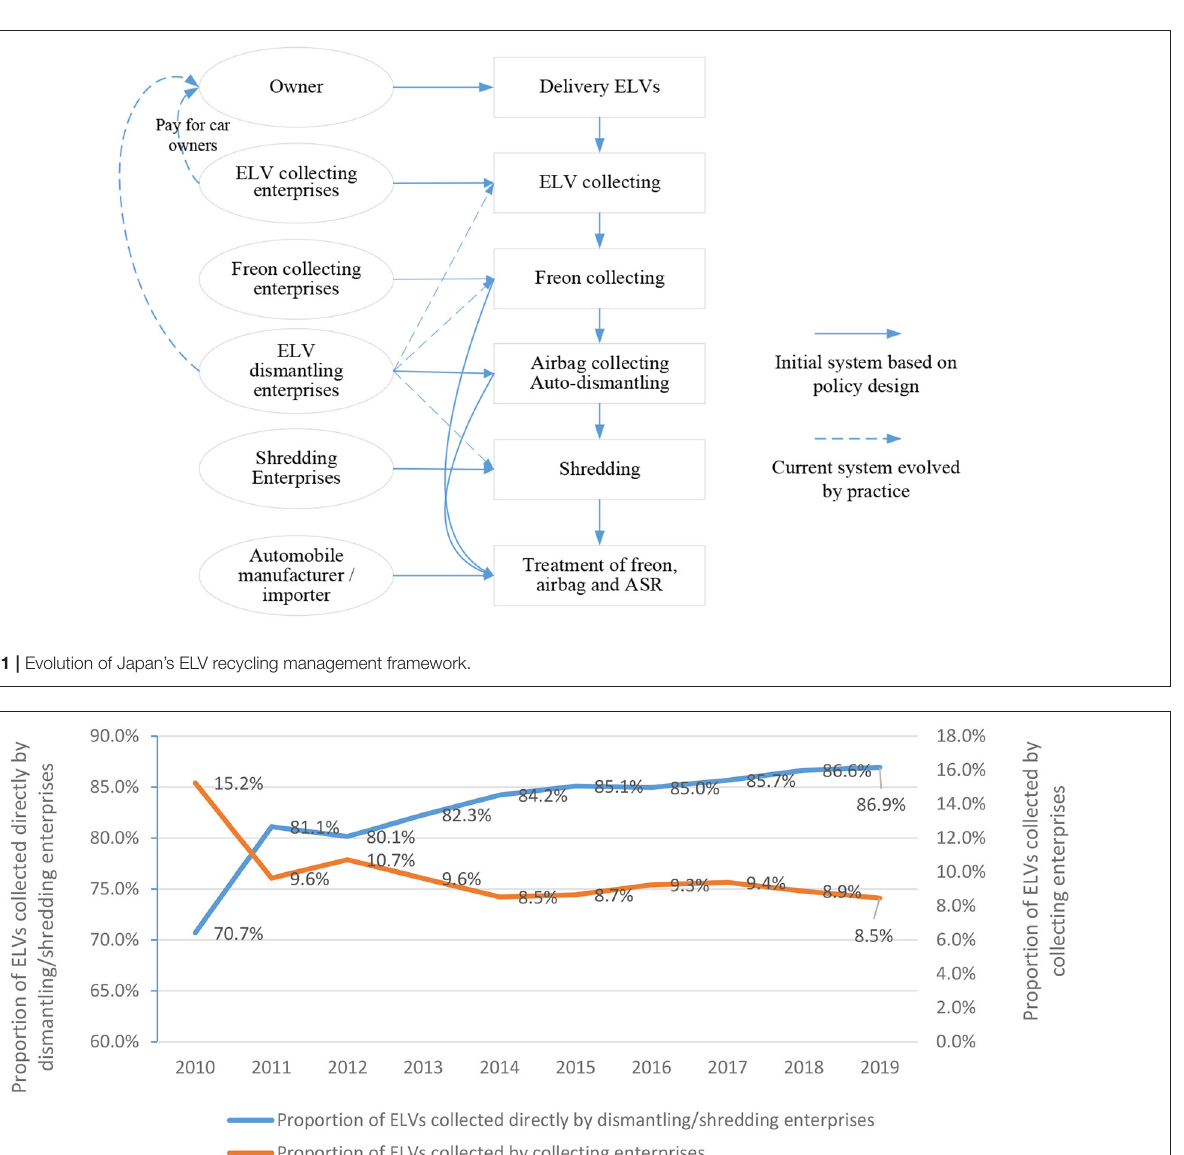
FIGURE 12 | The trend of proportion of ELVs being collected by various types of enterprises.